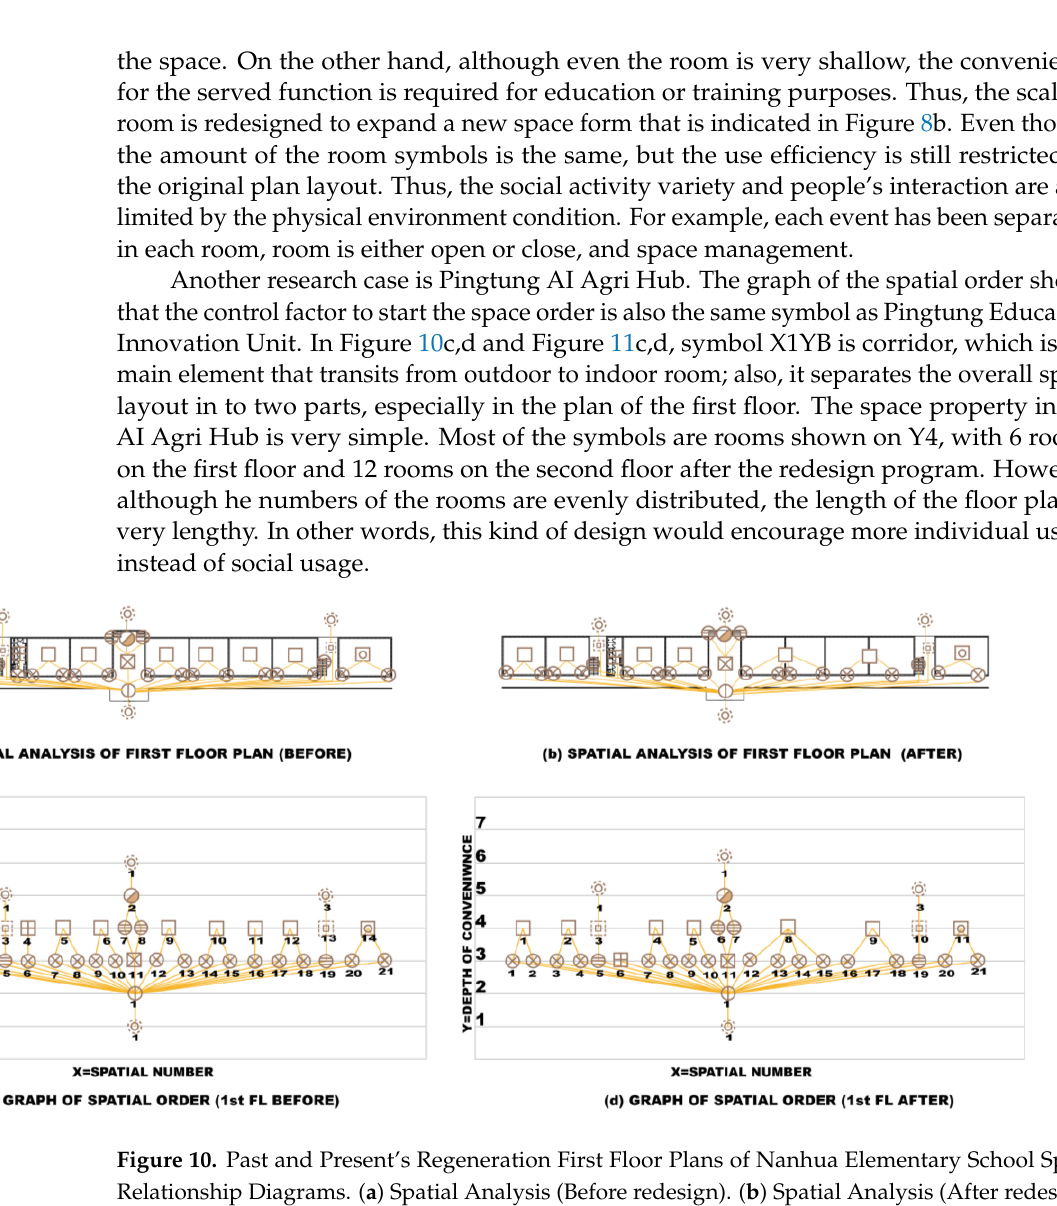
c yuan Branch’s Space Relationship Diagrams. ( a ) Spatial Analysis (Before redesign). ( b ) Spatial